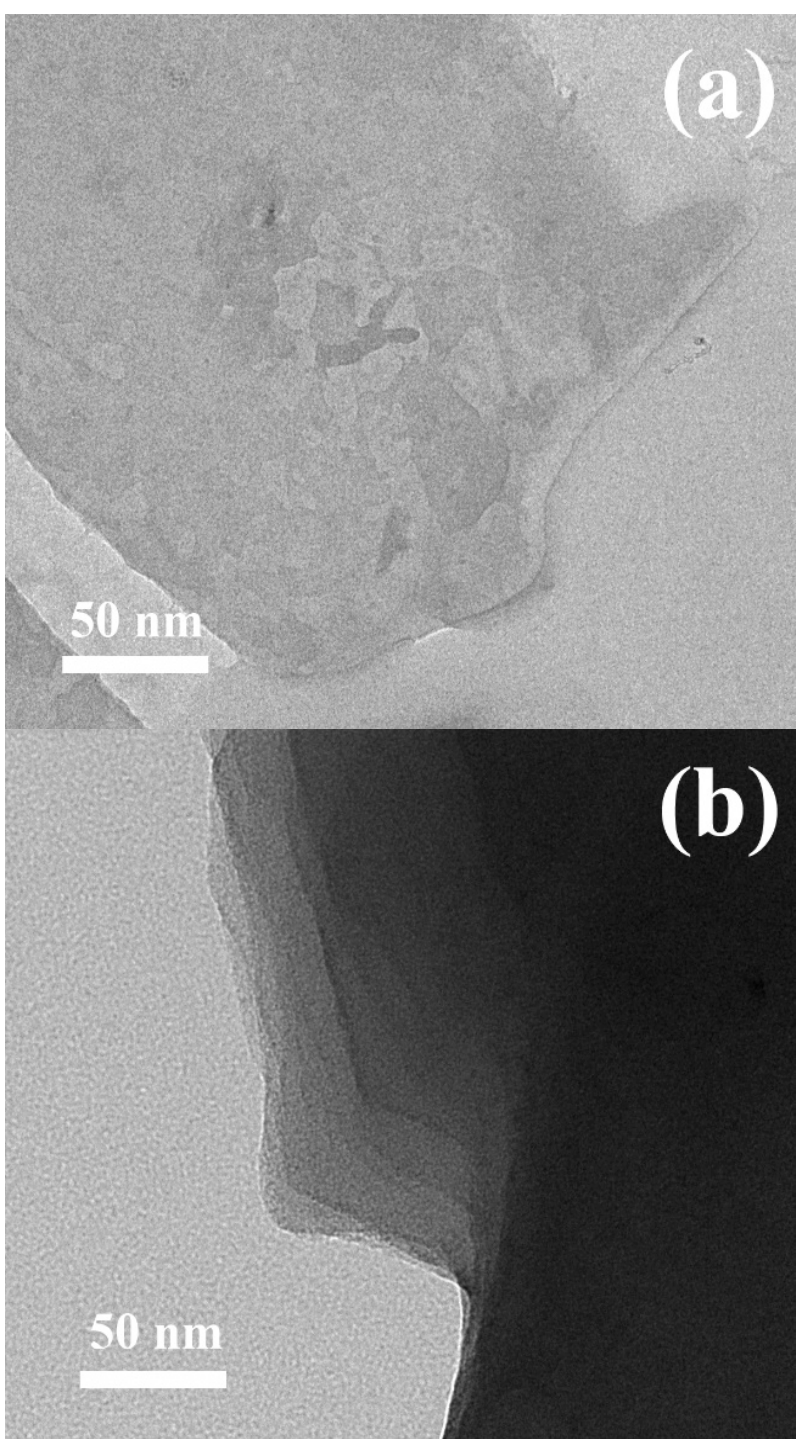
Figure 3. TEM images of the neat GO ( a ) and GO-PBA hybrid particle ( b ).